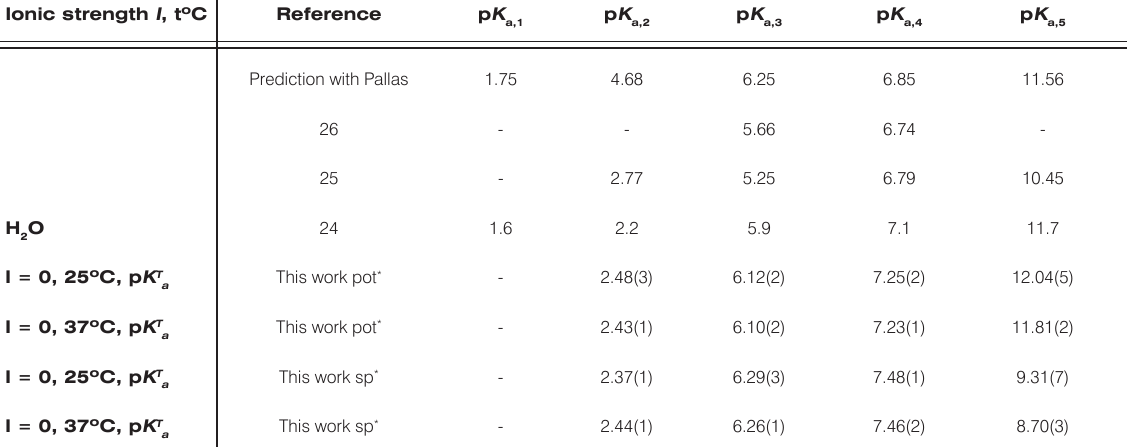
Figure 7. Plots of the dependence of the mixed dissociation constants p K potentiometrically (pot) on the square root of ionic strength, which lead to the parameter estimates of p K T p K T = 6.29(3) and 6.26(1), p K T = 7.48(1) and 7.46(2) and p K T a,3 a,4 Table